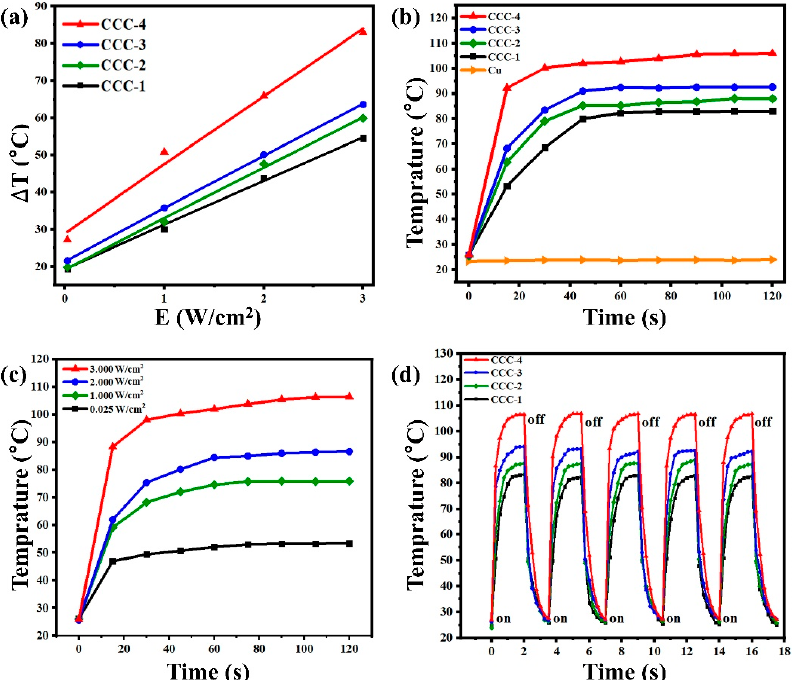
Figure 5. ( a ) Temperature gradient in CCC-x at 0.025, 1.0, 2.0, 3.0 W/cm 2 laser irradiation, ( b ) temperature gradient in CCC-x and Cu at 3.0 W/cm 2 laser irradiation for 120 s, ( c ) temperature gradient in CCC-4 at 0.025, 1.0, 2.0, 3.0 W/cm 2 laser irradiation for 120 s, and ( d ) photothermal cycling test of CCC-x at 3.0 W/cm 2 laser irradiation.